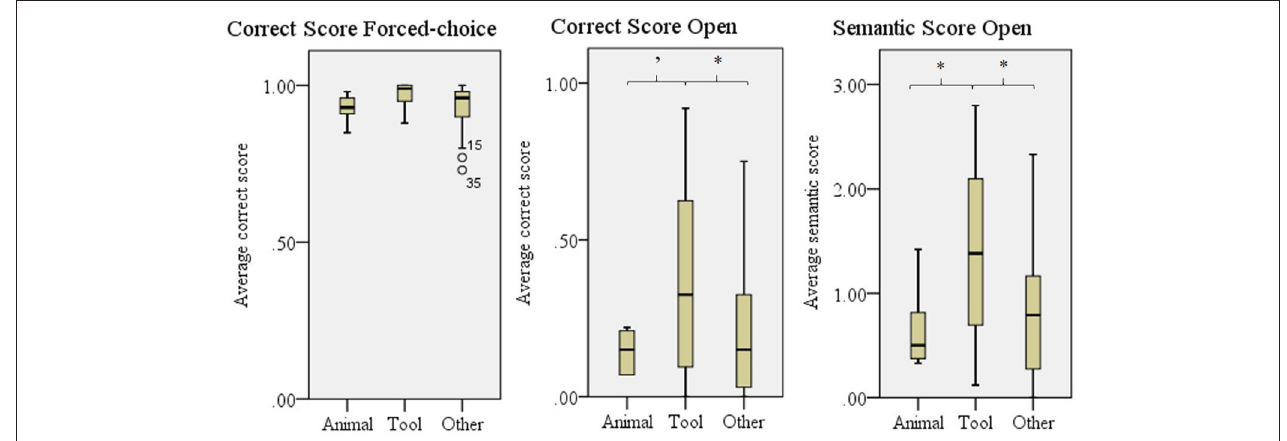
FIGURE 7 | Comprehensibility scores for animals, tools and other. Error bars show SD . ’ p = 0.070, * p < 0.050.